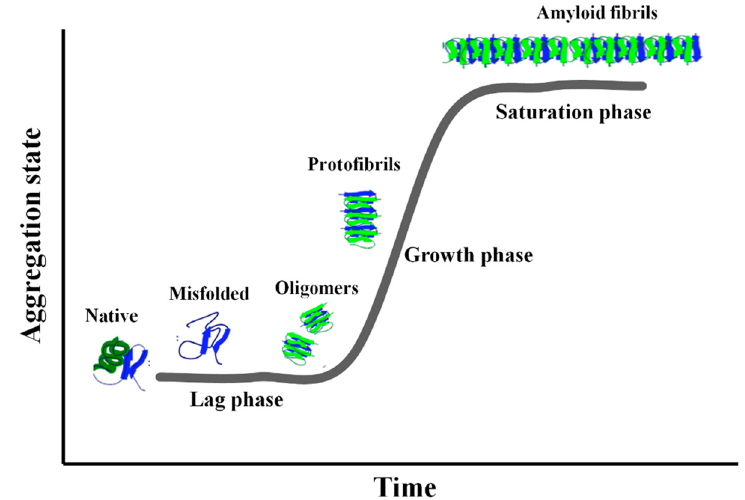
Figure 1. The typical aggregation curve of the amyloid proteins is characterized by three zones: “Lag- phase”, “Growth-phase” and “Saturation-phase”. The structure of the aggregates is also depicted (for the courtesy of Iannuzzi et al. [6]).